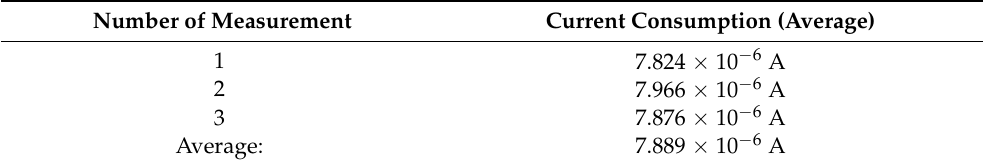
Table 3. Current consumption during sleep state of the WSM—measurement results.